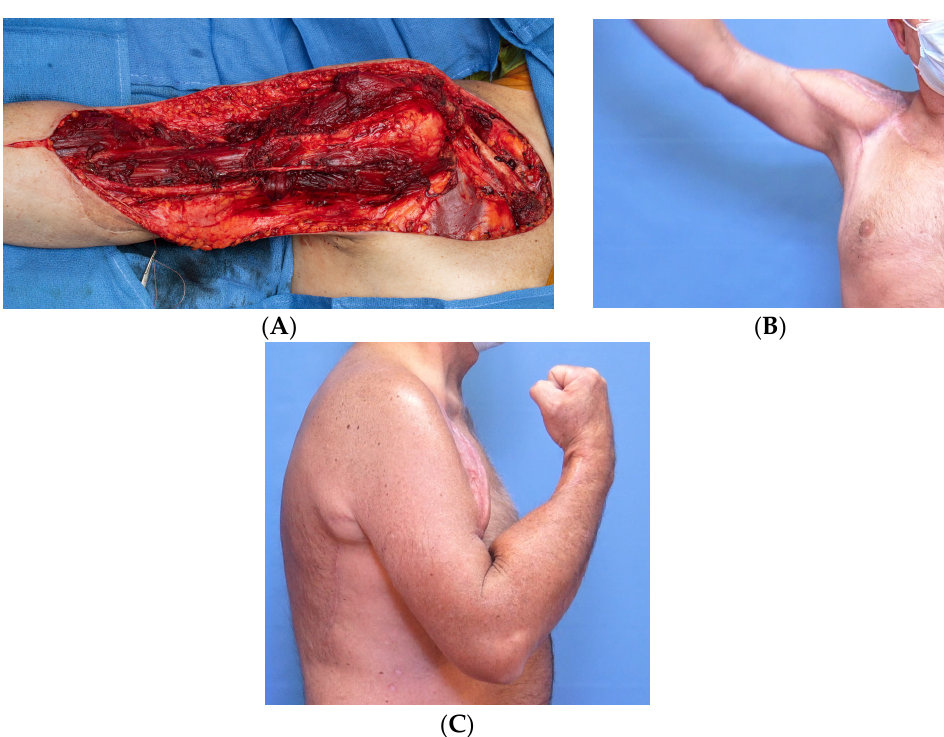
Figure 1. Intraoperative photograph showing resection of the entire anterior compartment of the arm ( A ). The tumor bed was reconstructed utilizing a pedicled functional latissimus flap, restoring forward elevation of the arm ( B ) and elbow flexion ( C ).